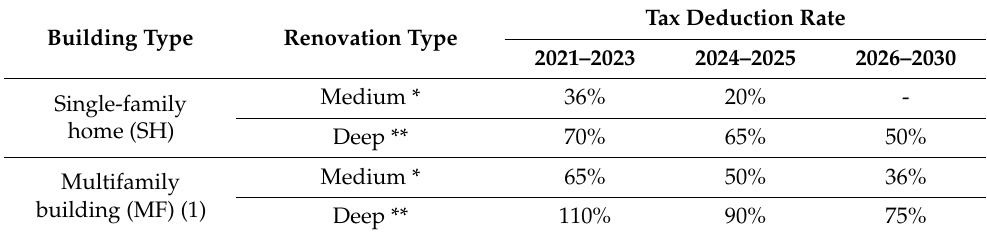
Table 11. Examples of possible evolution of the tax-deduction scheme aimed at improving energy efficiency in